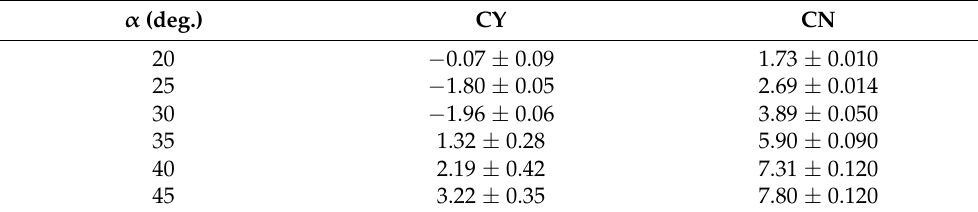
Table 2. Side and normal force coefficients versus angle of attack at Ma = 0.2, Re = 2 × 10 6 . Unstructured